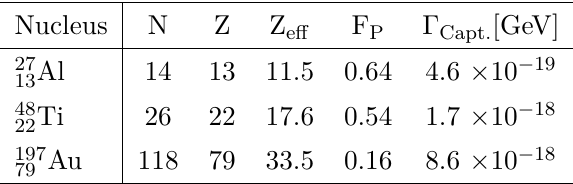
Table 1 . Input parameters for different